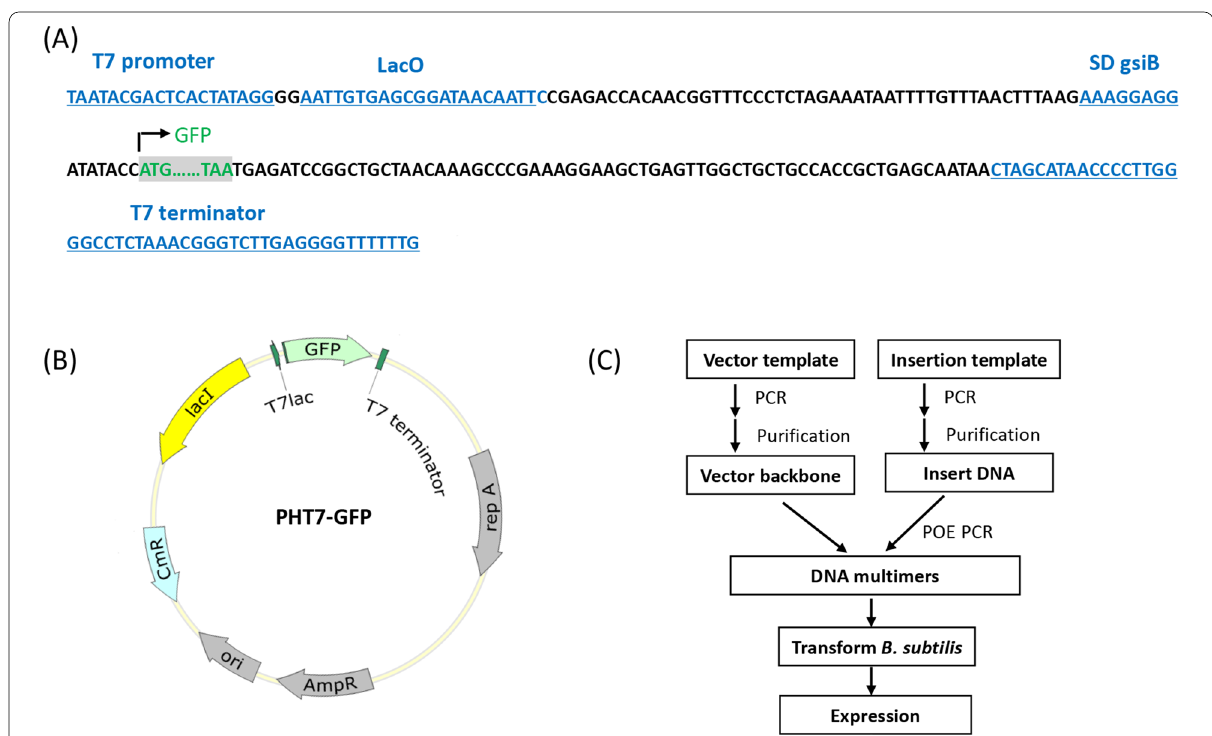
Fig. 2 Key DNA sequence before and after the gene of interest ( A ), plasmid map of pHT7‑GFP ( B ) and scheme of plasmid multimerization ( C ). Plasmid pHT7‑GFP contains the T7 promoter‑terminator cassette including a lacO lactose operator and a SD sequence, the replication origin ori in E. coli , the replication origin repA in B. subtilis , the lac repressor gene, chloramphenicol‑resistance gene and ampicillin‑resistance